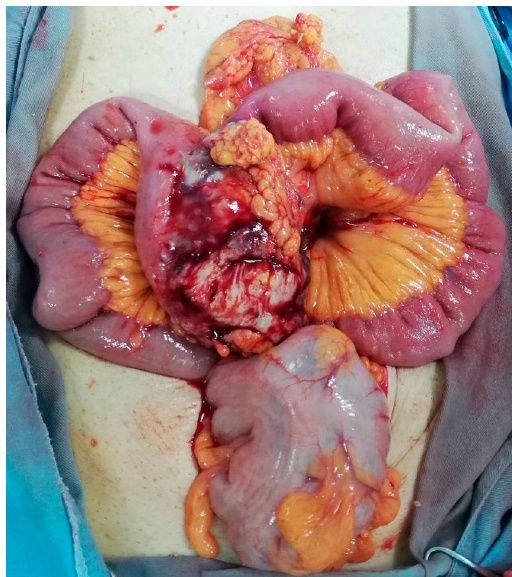
Figure 2. Macroscopic finding.